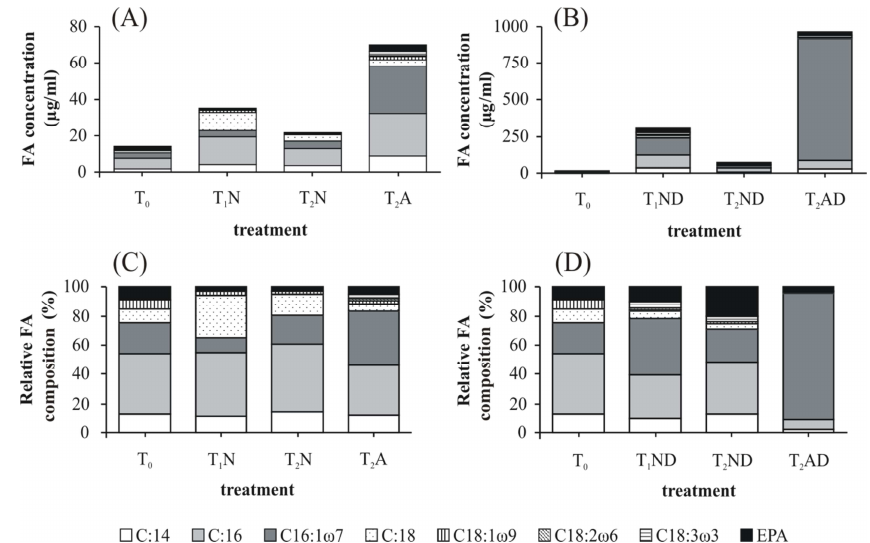
Fig. 6. Absolute and relative fatty acid composition of the sediment (0–3cm) for treatments without extra diatoms (A, C) and for treatments with diatoms (B, D) . Figure 6. Absolute and relative fatty acid composition of the sediment (0-3 cm) for treatments 3 without extra diatoms (A, C) and fortreatments with diatoms (B, D). 4